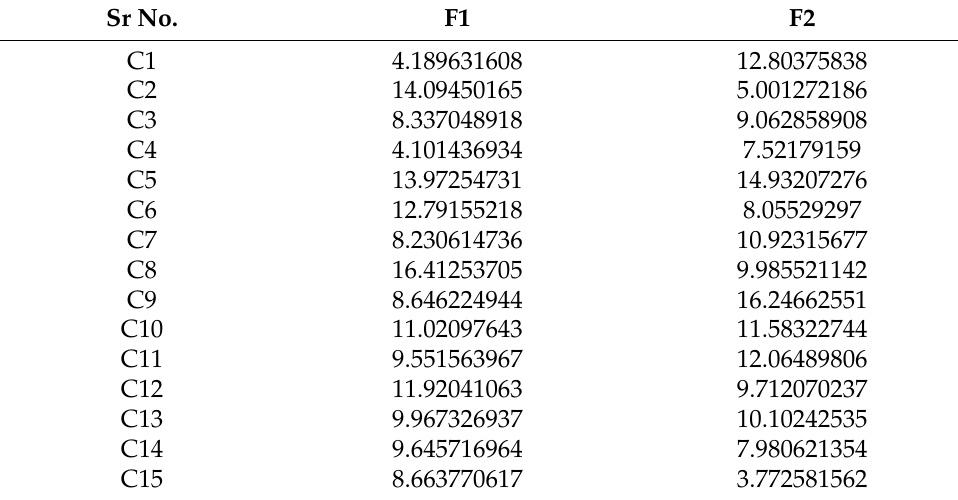
Table 11. The best centroids for R15 obtained by proposed